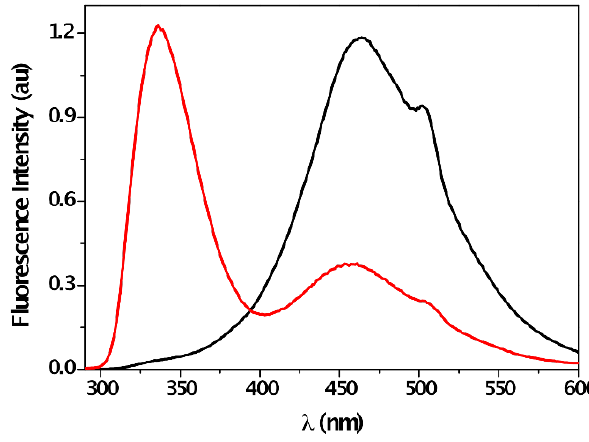
Figure 6. Emission spectra (λ exc = 320 nm) of a mixture of 1 ( c = 0.04 mM) and F¯ ( c = 2 mM) in acetonitrile in the absence (black line, right ) and in the presence of 10% methanol (red line, left ).